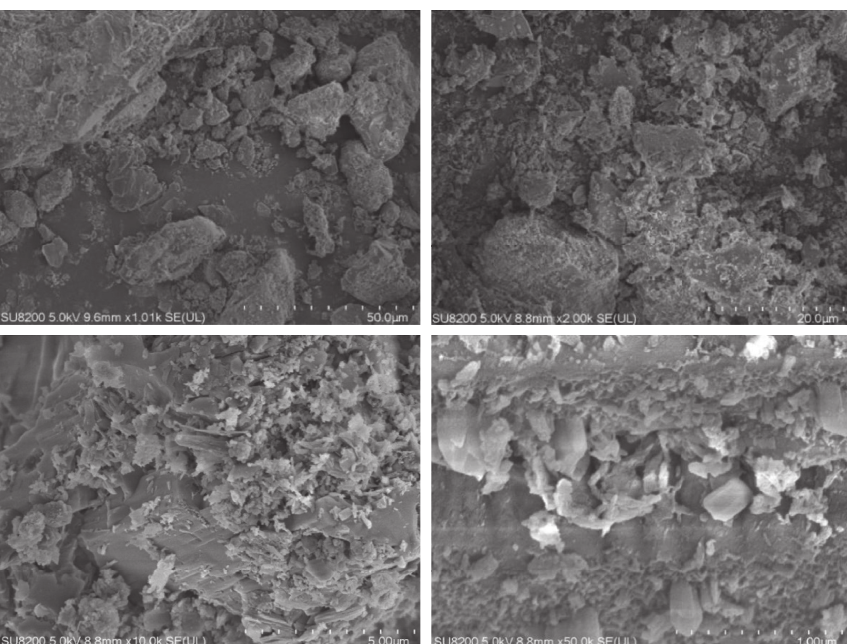
Figure 7: Microstructure of Group